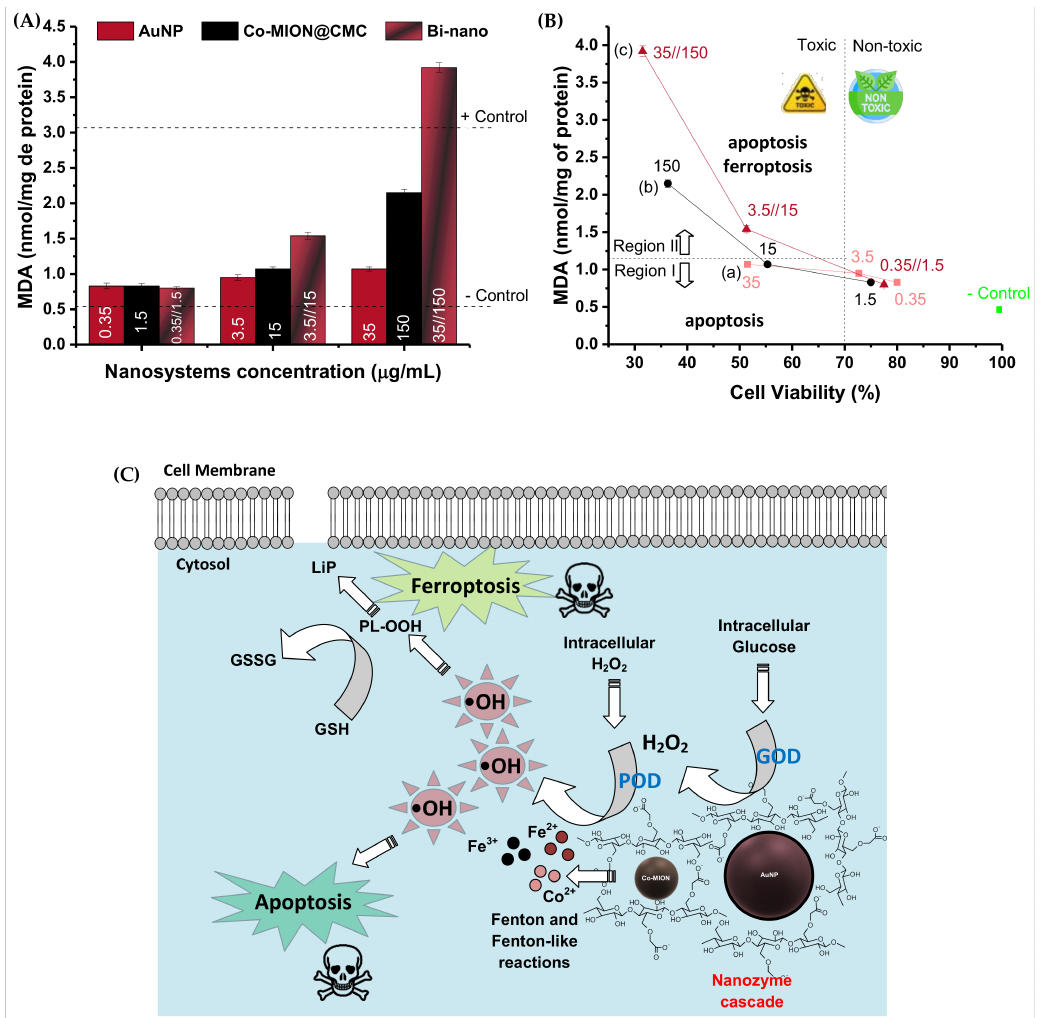
Figure 8. ( A ) Results of lipid peroxidation assessed by malondialdehyde (MDA) levels. ( B ) Compari- son of MTT and MDA results for evaluating toxicity mechanisms (( a ) AuNP, ( b ) Co-MION@CMC, and ( c ) Bi-nano). ( C ) Schematic representation of cell death pathways/mechanisms (e.g., apoptosis and ferroptosis) provoked by nanozyme cascade